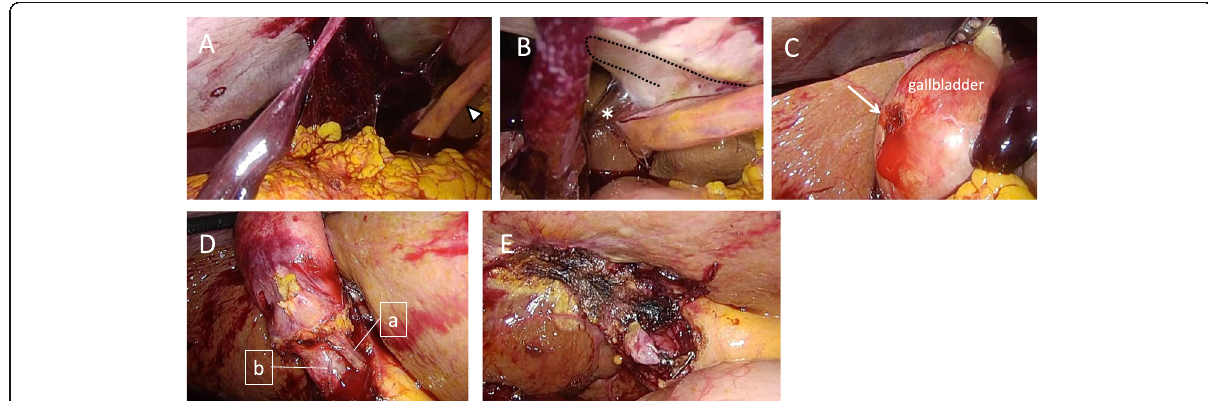
Fig. 2 Intraoperative laparoscopic views. A Wide-spread hemorrhagic ascites in the sub-hepatic area. The arrowhead indicates the round ligament. The presence of the LVAD main body and driveline did not obstruct the operating field. B Inserting the epigastric port (asterisk) while avoiding injury to the driveline (dotted line). C The bleeding point (arrow) was at the gallbladder serosa. D Standard view of LC: cystic artery (a) and cystic duct (b). E View after gallbladder